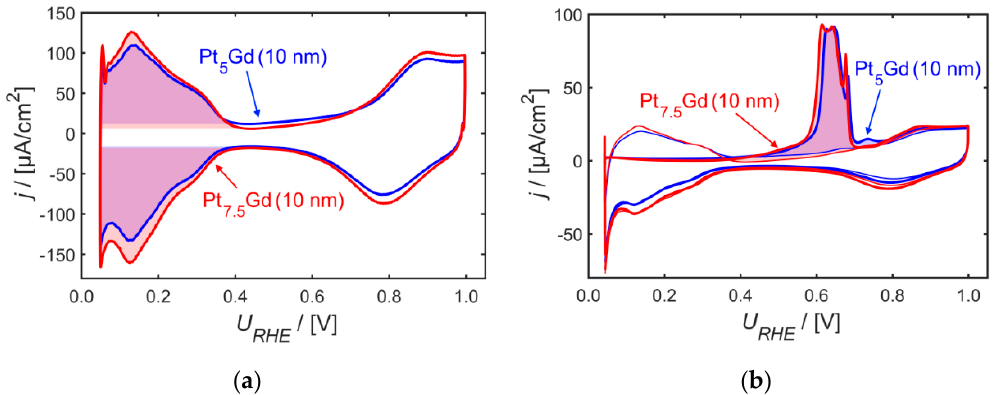
Figure 2. Cyclic voltammograms on 10 nm Pt 5 Gd (blue curves) and Pt 7.5 Gd (red curves) thin films in 0.1-M HClO 4 ; ( a ) Base cyclic voltammograms (CVs) in N 2 -saturated electrolyte taken at 50 mV/s; ( b ) CO-stripping measurements at 10 mV/s. Sketched areas of ( a ) and ( b ) correspond to charge areas used for evaluating H adsorption and CO oxidation, respectively. All current densities were normalized to the geometric electrode area of ~0.196 cm 2 . Table 1. Fitted extended X-ray absorption fine structure (EXAFS) and electrochemical characterization data for Pt x Gd (10 nm) samples as prepared and after electrochemical conditioning, the latter denoted by “*”. All EXAFS strain data relied on a Pt foil reference measurement [21] in which a relaxed Pt–Pt bond length of 2.775 Å was established, see S.I. EXAFS data are given with ± 0.01 Å. This corresponds to a strain error of about 0.4%.